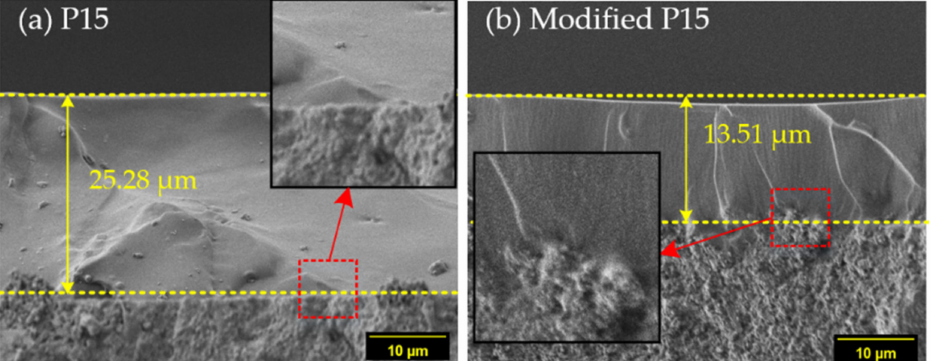
Figure 10. SEM images of the PDMS layer supported on the ceramic substrate: ( a ) P15 and ( b ) modified P15 prepared at 75 and 120 ◦ C for 12 h, respectively.